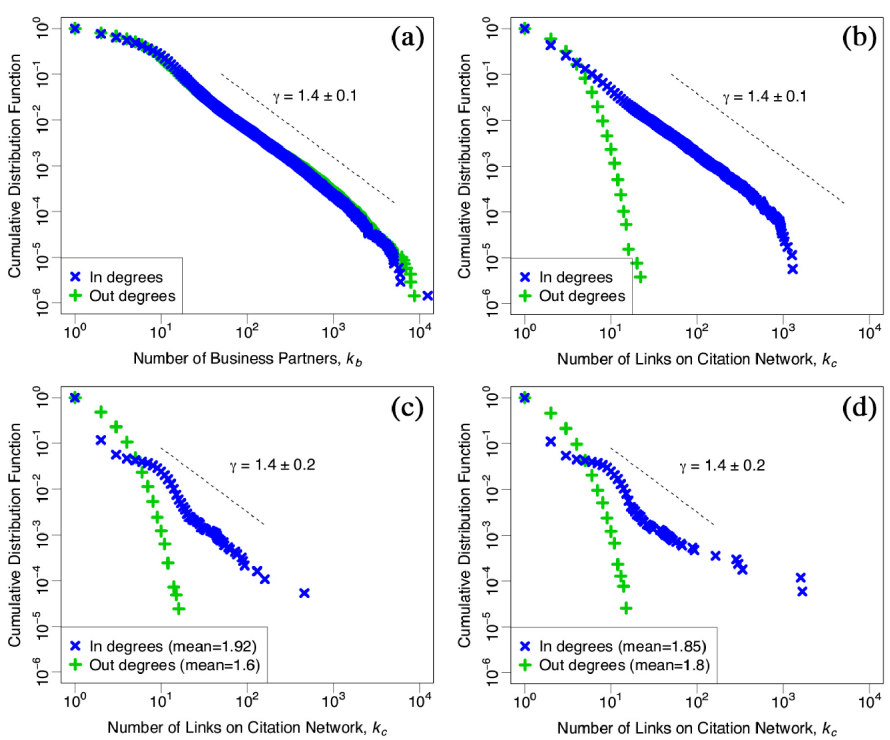
Fig 2. Cumulative distributions of in- and out-degree in 2018 in a log-log scale plot. Each panel (a) and (b) shows this distribution on the inter-firm business transactions network and on the citation network, respectively. Each green plus-mark and blue cross shows out-degrees and in-degrees, respectively. Each panel (c) and (d) shows this distribution generated by newcomers and disappears on the citation network, respectively. Each mean number of in- degrees is about 1.92 in panel (c) and 1.85 in panel (d), respectively, and each mean number of out-degrees is about 1.60 in panel (c) and 1.80 in panel (d),